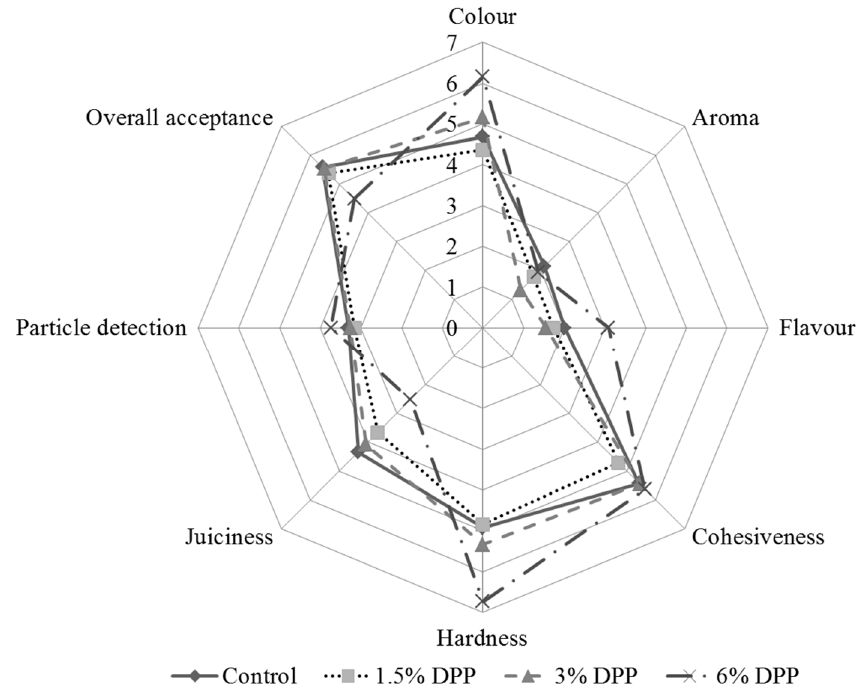
Figure 3. Results of the sensory analysis (consumer panel) in cooked burgers with date pit powder (DPP).